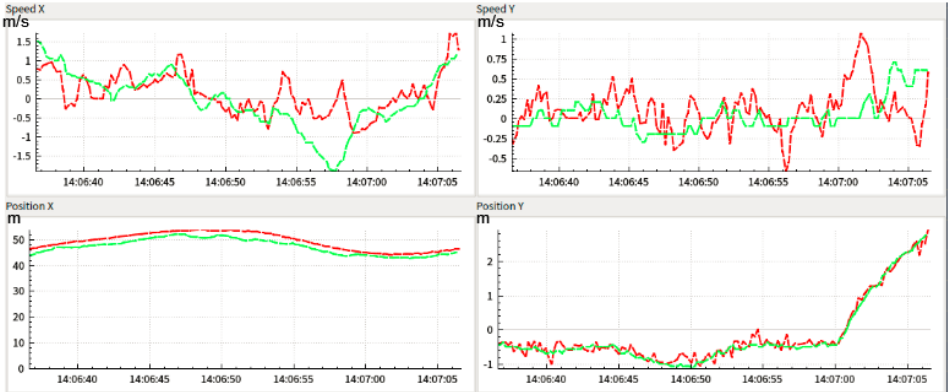
Figure 13. The longitudinal and lateral velocity and position of the target vehicle relative to the ego- vehicle.